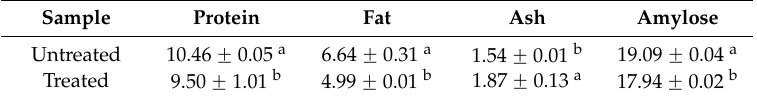
Means with different letters in same column differ significantly ( p < 0.05), n = 2.